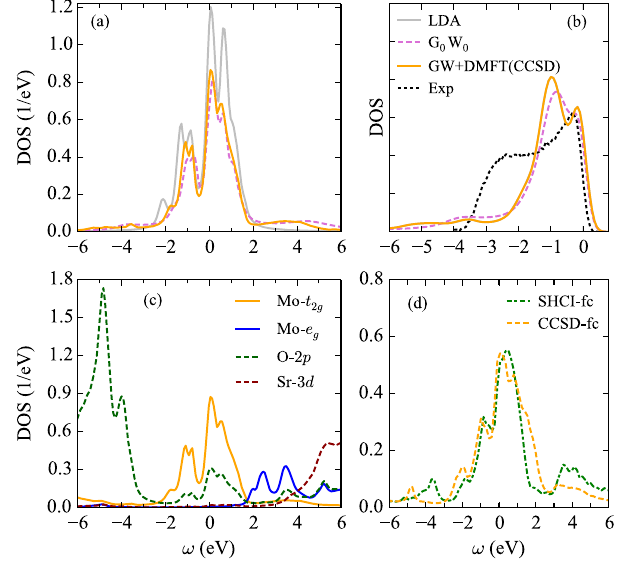
FIG. 6. Full cell GW þ DMFT results for paramagnetic SrMoO 3 based on the LDA reference. (a) Local DOS of Mo- t 2 bands computed with a broadening of 0.15 eV. (b) Com- g parison of G 0 W 0 and GW þ DMFT with photoemission exper- imental data [99]. A Fermi function of 298 K and a Gaussian filter of 0.2 eV are applied to the calculated DOS to match the experimental resolution. (c) Orbital-resolved DOS computed by GW þ DMFT (CCSD). (d) Comparison of GW þ DMFT DOS (Mo- t 2 bands) using CCSD and SHCI solvers in a frozen- g core correlated